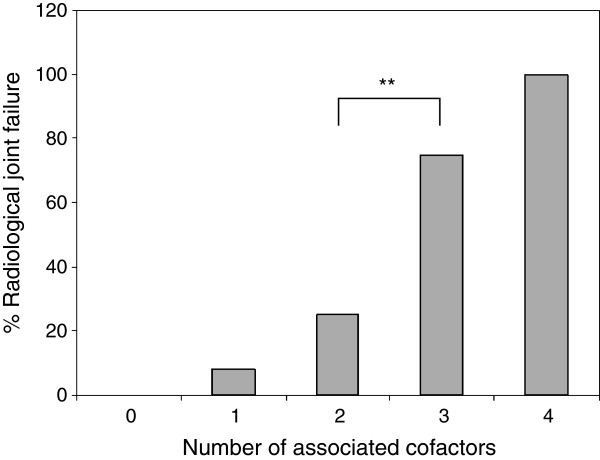
The percentage of radiological joint failure increases in case of increasing number of associated cofactors (hip dislocation, intraarticular fragments, femoral head or acetabular joint surface impaction, initial displacement >10mm). ** p = 0.001.